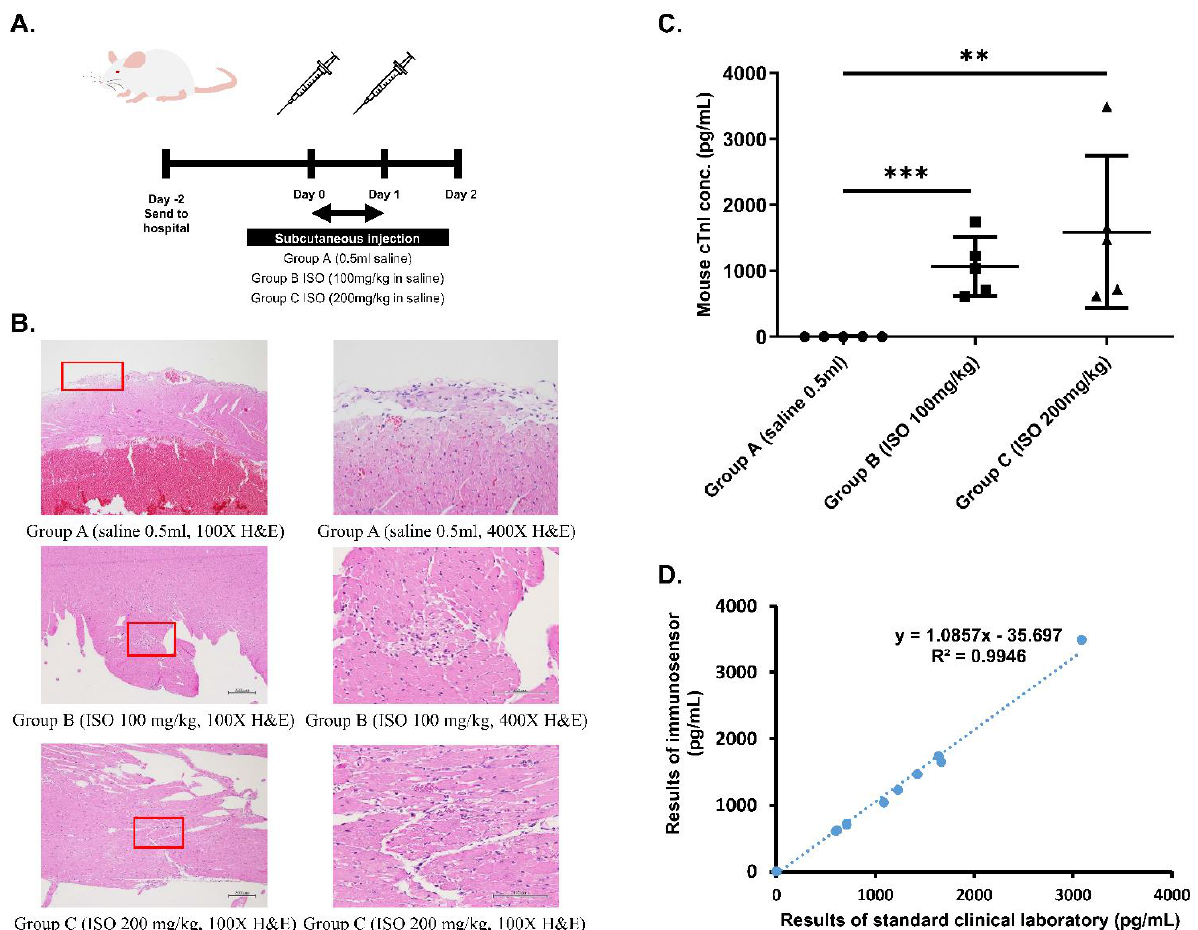
Figure 2. Establishment of cardiac damage mouse model. ( A ) Schedule of ISO injection in Balb/c mice. Mice were randomized into Group A (0.5 mL saline), Group B (100 mg/kg ISO in saline), and Group C (200 mg/kg ISO in saline). ( B ) IHC staining of heart tissue from mice in different groups at 100 × and 400 × magnification. Areas that were magnified to produce 400 × images are boxed in red. ( C ) Statistical analysis of differences in cTnI measurements obtained using immunosensor between mice from the three groups. ** p ≤ 0.01, *** p ≤ 0.001. ( D ) Correlation between immunosensor detection method and standard clinical laboratory detection method in mouse model samples.